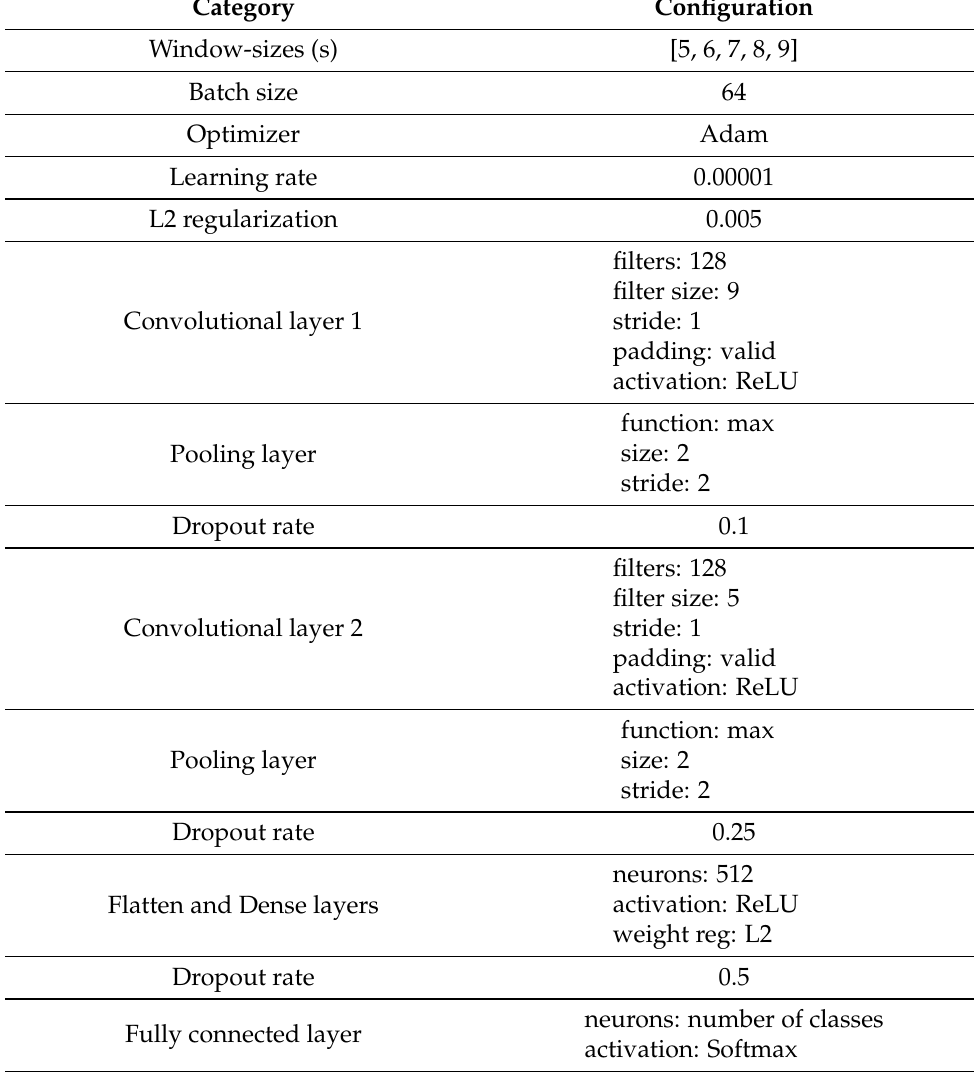
Table A1. PAMAP2 DTE-CNN model configuration.